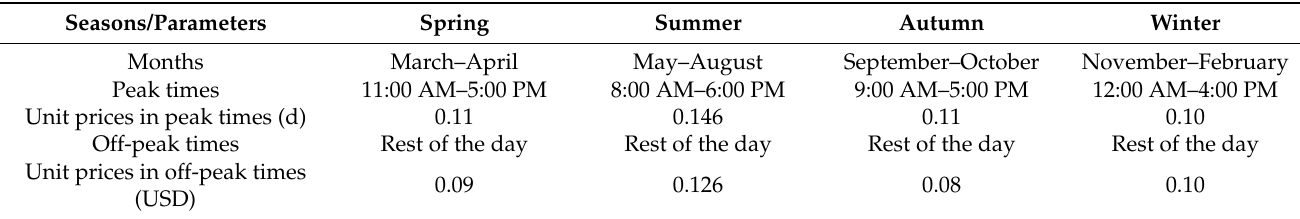
Table 4. Different case study